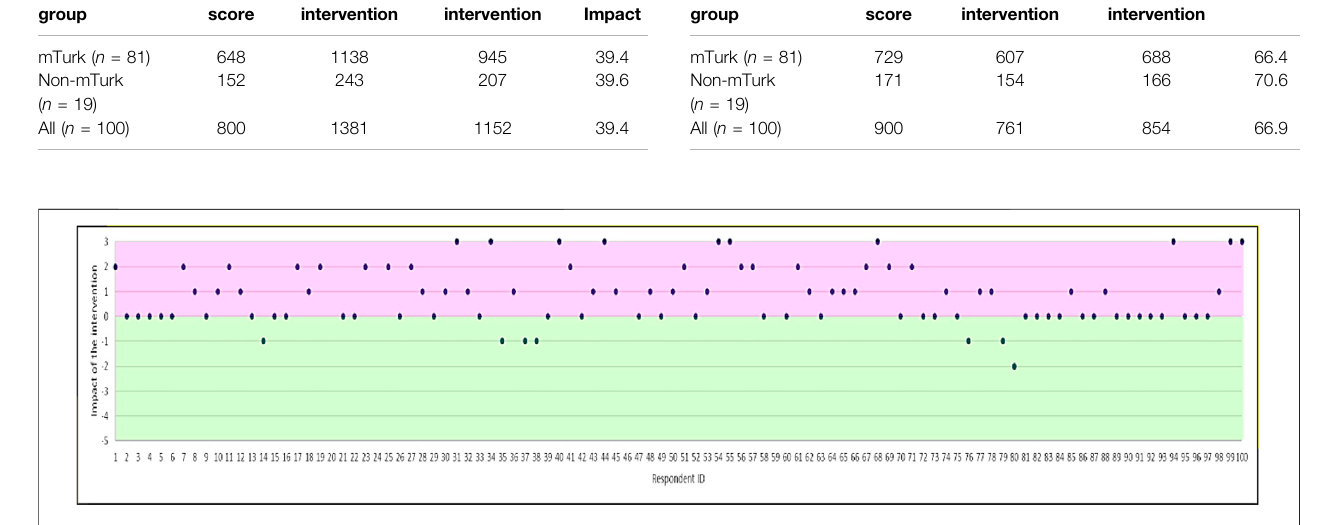
FIGURE2| MagnitudeofchangeinConcerns(differenceintotalscorefortheconcernssubscale).Positiveeffectoftheinterventionisshowninpurple(i.e.increase in concerns), and negative effect in green.